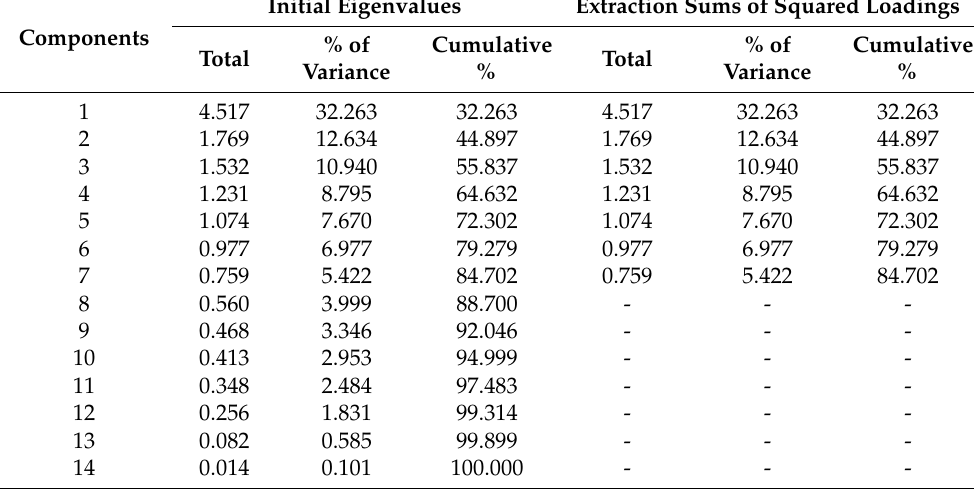
Table 3. Total variance